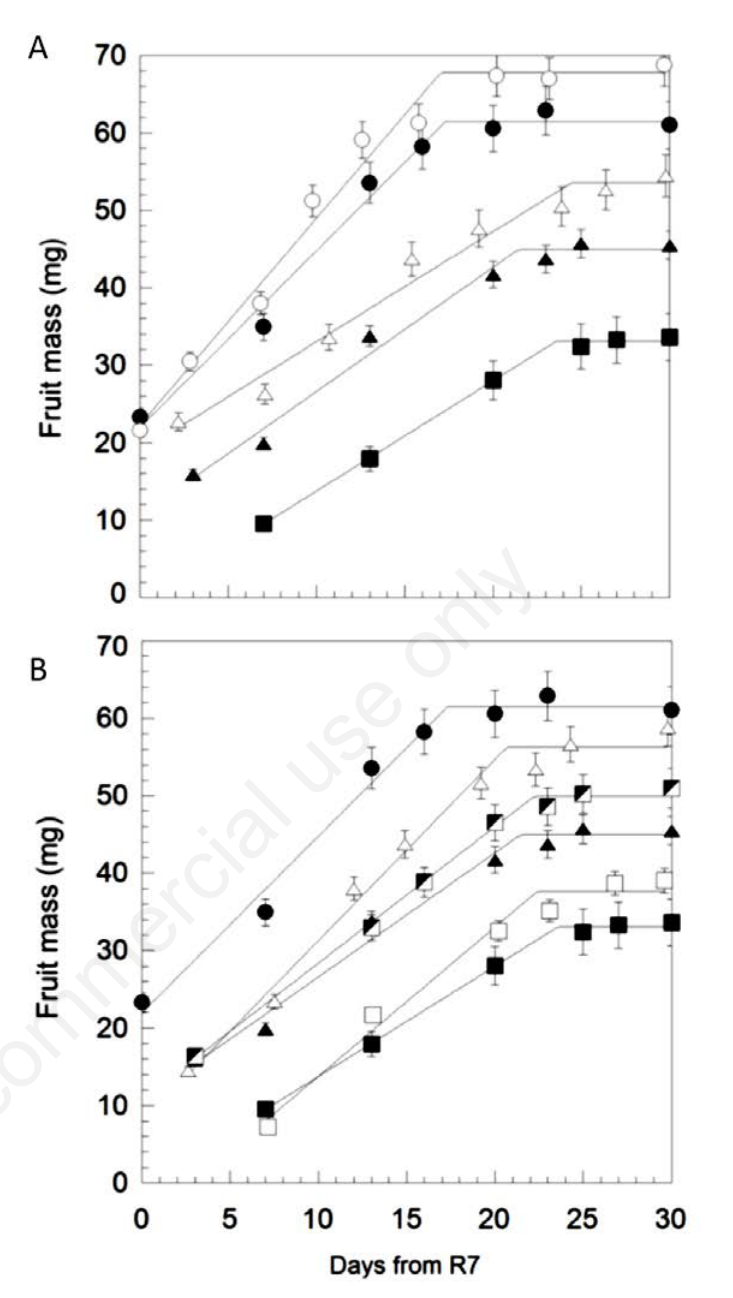
Figure 2. Evolution of achene dry mass (ADM) from R7 up to harvest maturity for the controls plants (closed symbols) and treated plants (open symbols) respectively. A) Control plants vs. external ring of florets removed (OR) and external ring removed plus a peripheral constraint (OR+PC). B) Control plants vs. internal ring of florets removed (IR). (  ,  ) external achenes; ( p , r ) middle achenes; (  ,  ) internal achenes, ( ) middle achenes when an artificial peripheral constraint was applied. For this last treat- ment data for the internal achene mass is not shown. Vertical bars: ±1 SE. Fitted values are shown in the following